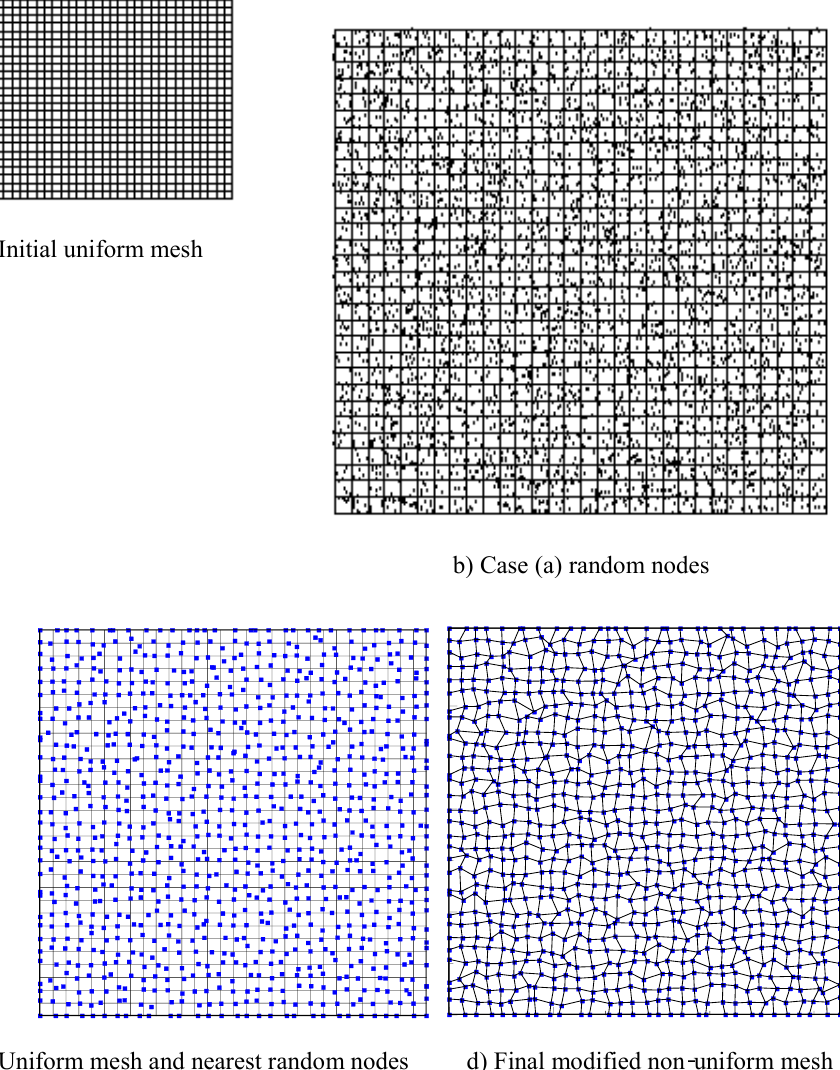
Fig. 3. A typical random mesh